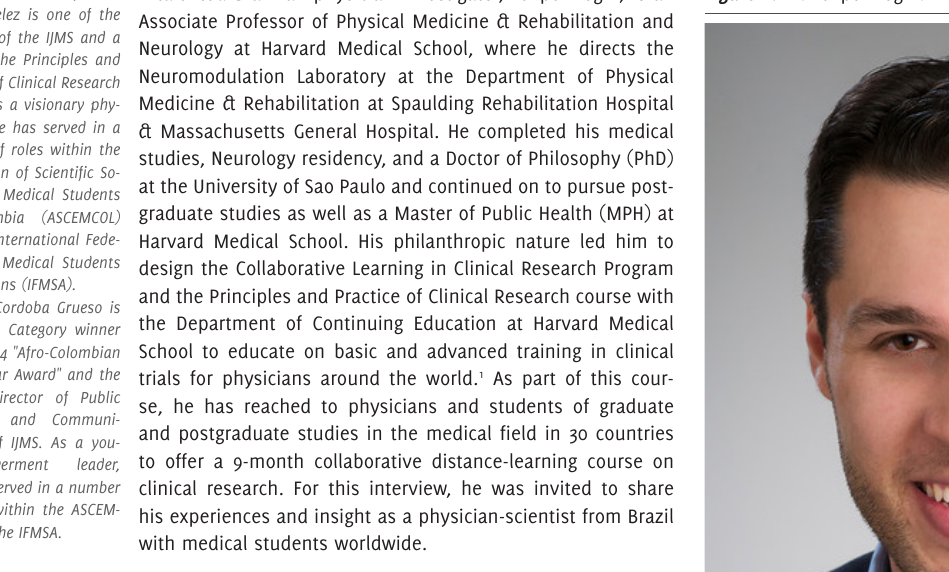
Figure 1. Dr. Felipe